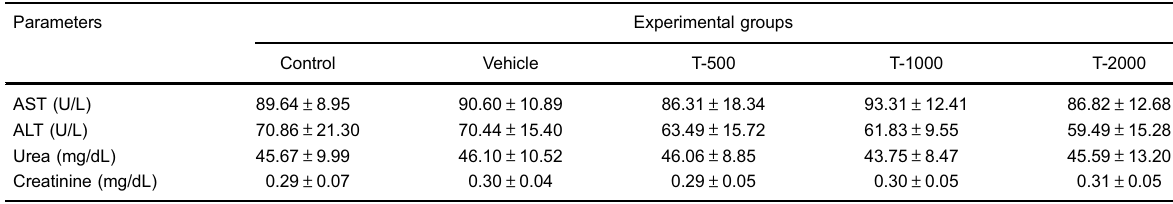
Table 1. Plasma markers of hepatic and kidney injury of Wistar rats treated postpartum with valerian.